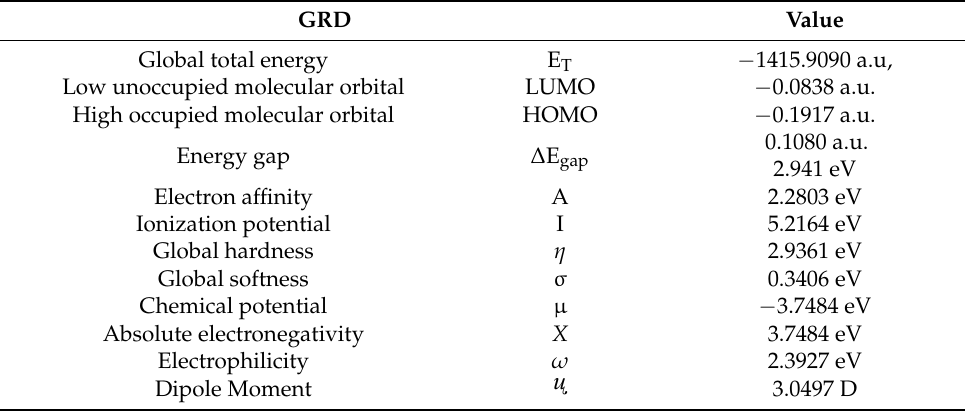
Table 4. Calculated GRD quantum